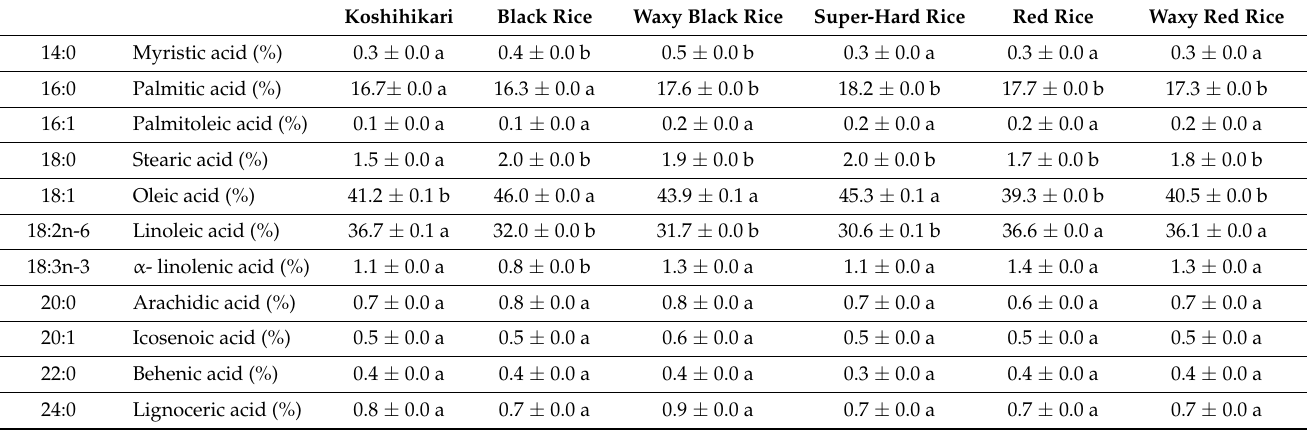
Table 2. Fatty acid compositions of six kinds of japonica rice bran.